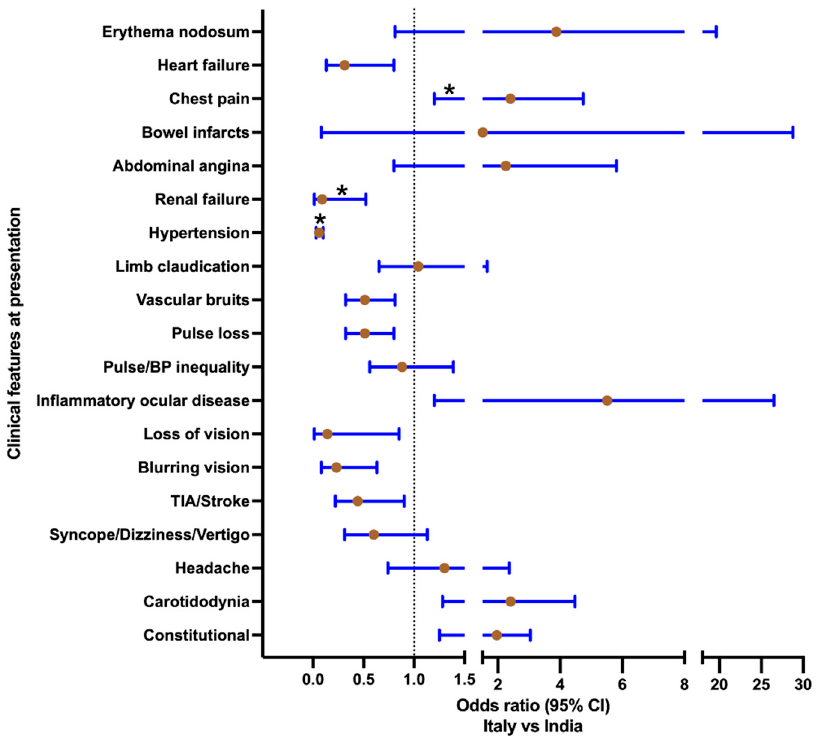
Figure 1. Comparison of clinical features at presentation in patients with Takayasu arteritis from Italy and India. Odds ratio (95% confidence intervals) presented for odds ratio for clinical features at presentation for Italy vs. India (Italy, n = 127; India, n = 191). Those comparisons marked with an asterisk were different between the two cohorts with p < 0.05 after correction for multiple